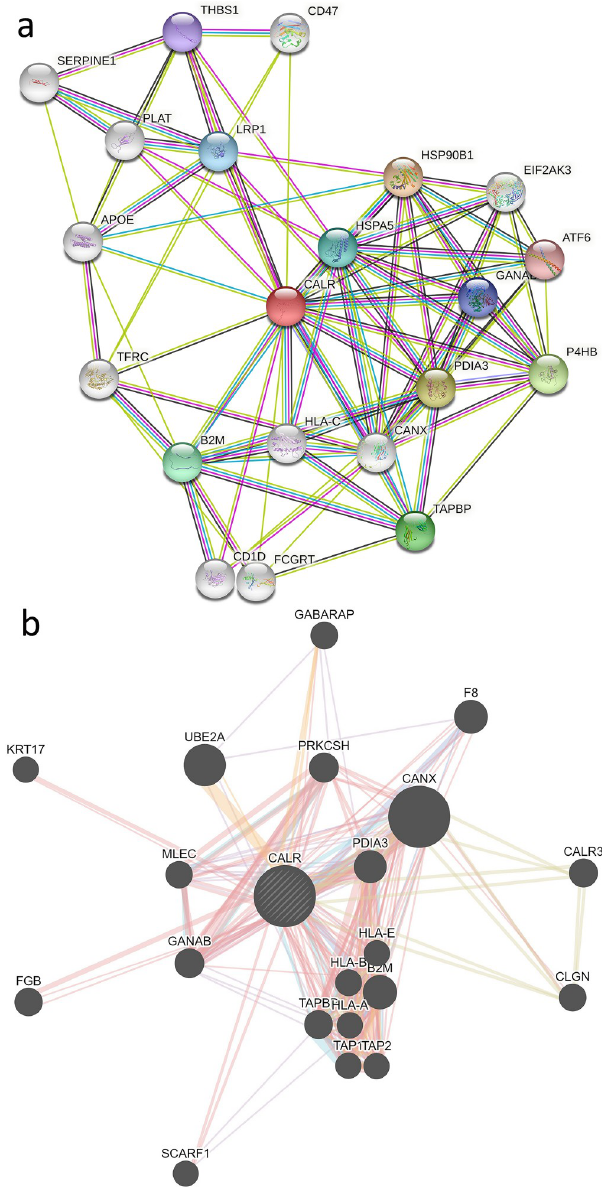
Fig 7. Protein-protein interaction network of CALR. (a)The top 21 proteins associated with CALR based on the STRING database. (b)The interacted genes with CALR according to the GeneMANIA